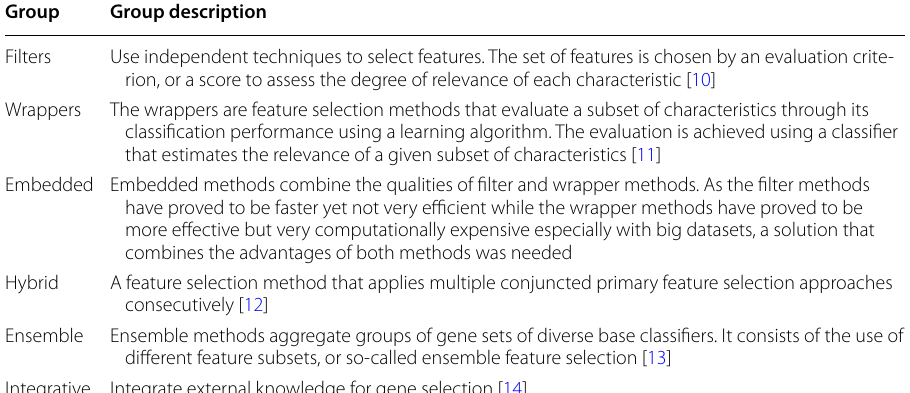
Table 1 Groups of feature selection algorithms